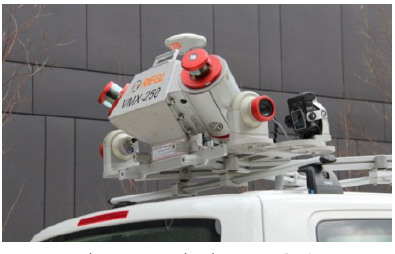
Figure 5. Riegl VMX-250